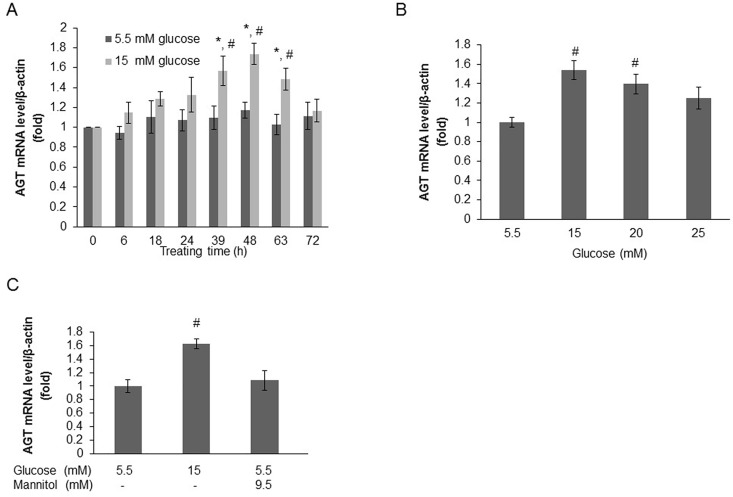
High glucose augments AGT mRNA level in HK-2 cells in a time- and dose-dependent manner.(A) AGT mRNA levels measured at different time points in HK-2 cells respectively treated with normal glucose (5.5 mM) and high glucose (15.0 mM). Compared with normal glucose treatment, high glucose significantly augmented AGT mRNA level from 39 h to 63 h. (B) AGT mRNA levels measured in HK-2 cells respectively treated with different glucose concentrations for 48 h. Compared with normal glucose treatment, high glucose augmented AGT mRNA level with the most significant effects by 15.0 or 20.0 mM glucose. (C) The effect of high glucose on AGT mRNA level was not due to osmotic stress which was further balanced with mannitol treatment for 48 h. Data are expressed as relative values to the 0h group (A) or normal glucose group (B and C). Values are presented as mean ± SEM. *P<0.05 vs. 0h group with the same glucose concentration; #P<0.05 vs. normal glucose group with the same treating time. N = 3~6.